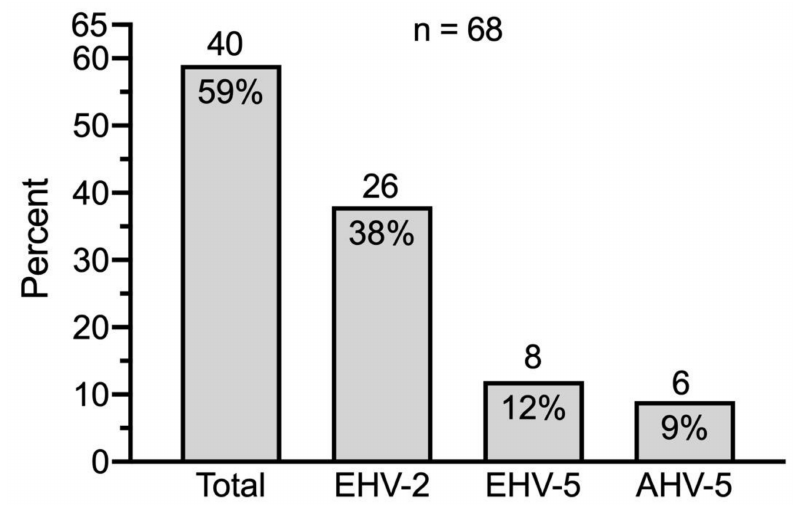
Figure 3. Prevalence of eGHV in nasal swabs of healthy Swiss horses ( n = 68). Absolute numbers of horses are indicated above the columns.